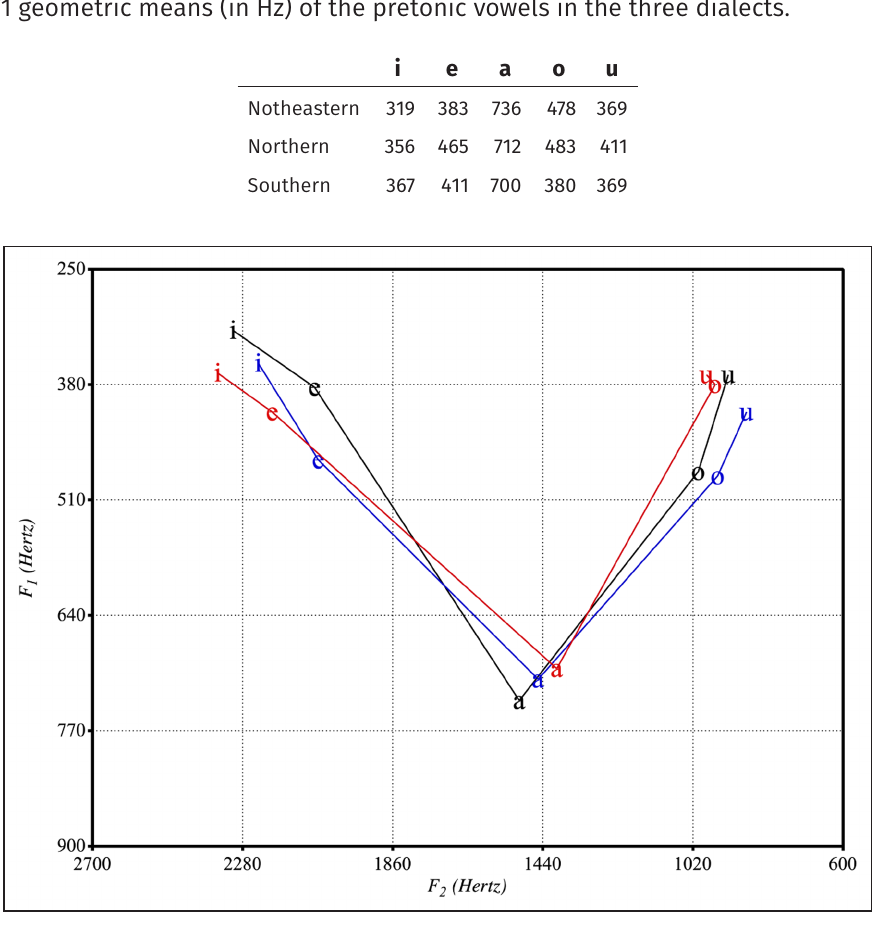
Figure 2: Mean of the first and second formant of the 4400 pretonic vowel tokens, grouped by dialect (black = NE-D, blue = N-D, red =